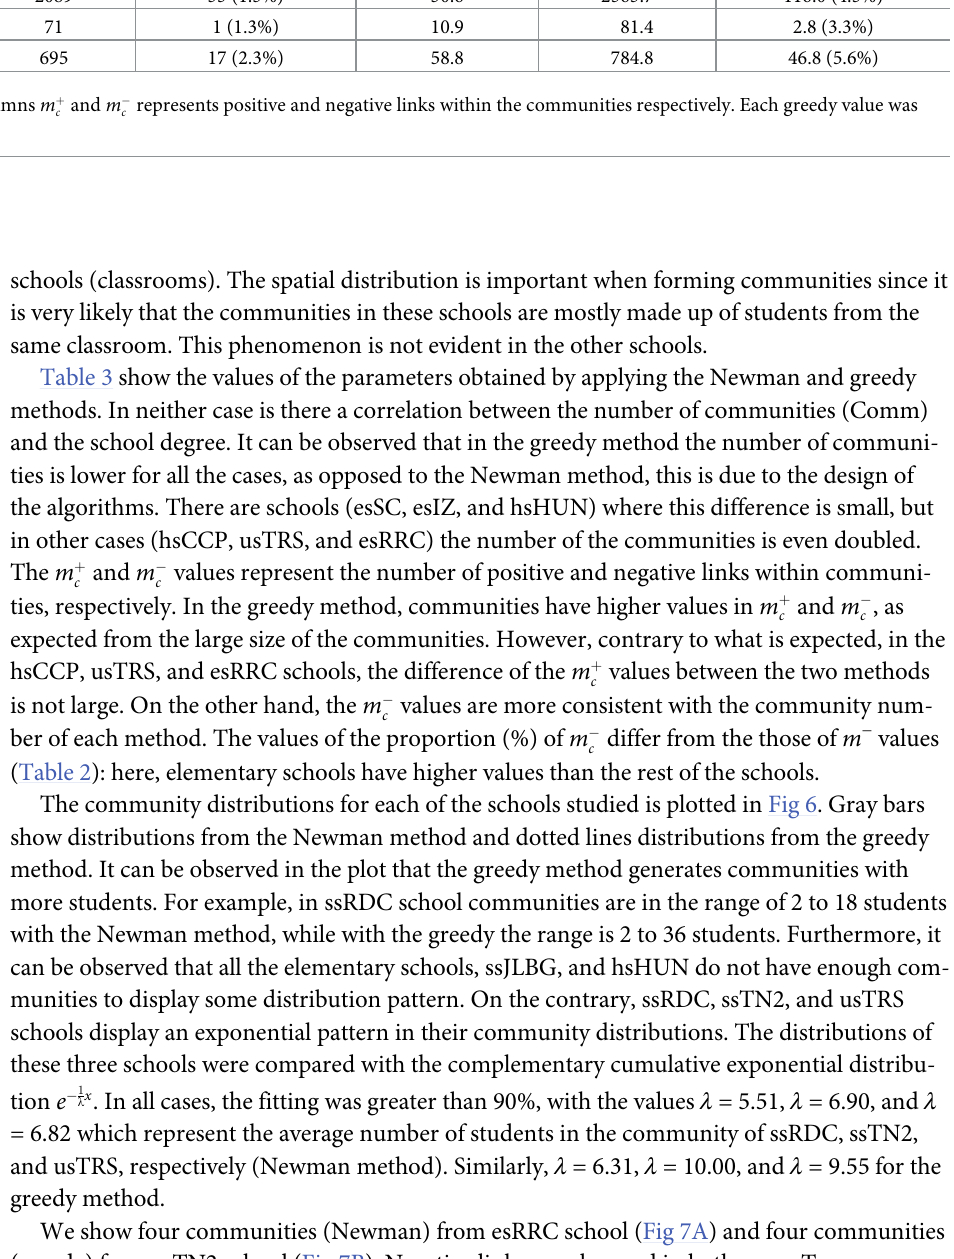
and m (cid:0) represents positive and negative links within the communities respectively. Each greedy value was c c